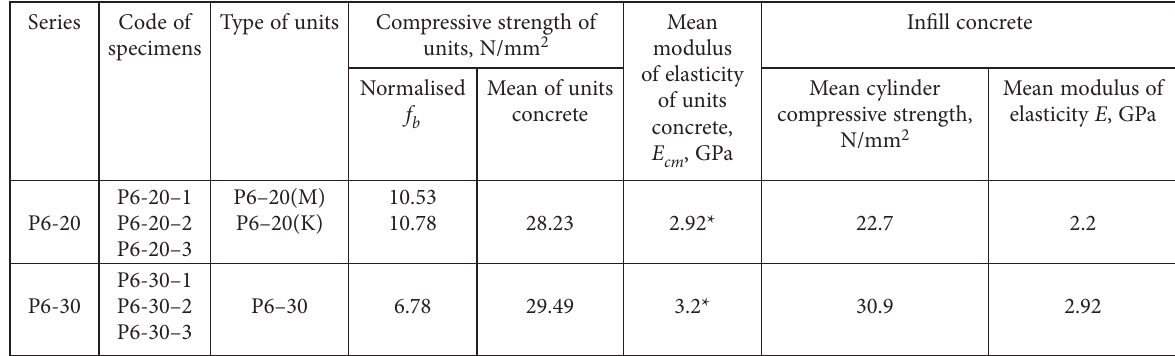
Table 1. Masonry unit and infill concrete